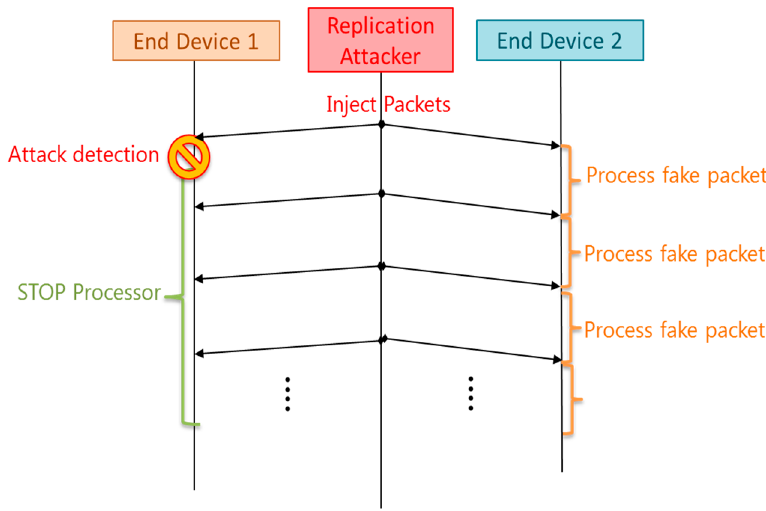
Figure 13. Firmware running under replication attack conditions.